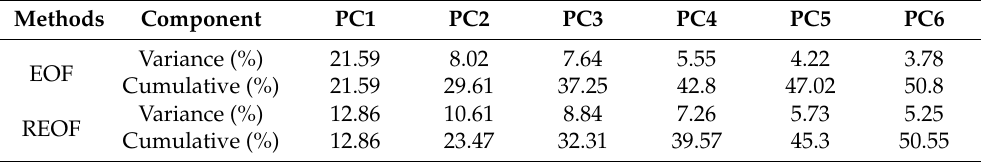
Table 1. Variance contributions after EOF and REOF changes based on SPEI12.